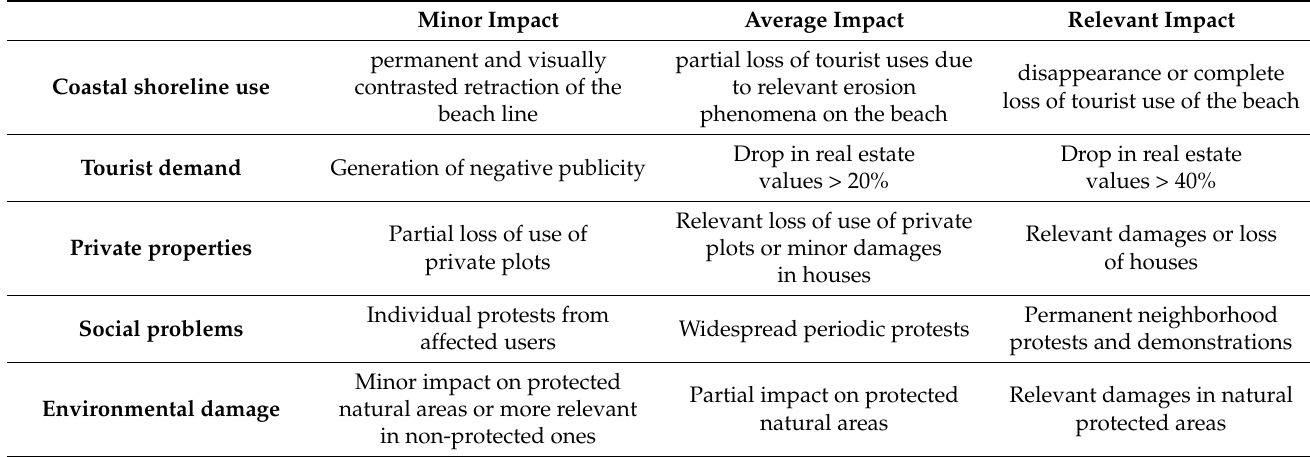
Table 1. Criteria to establish the impact level for different cases in the GSI index.